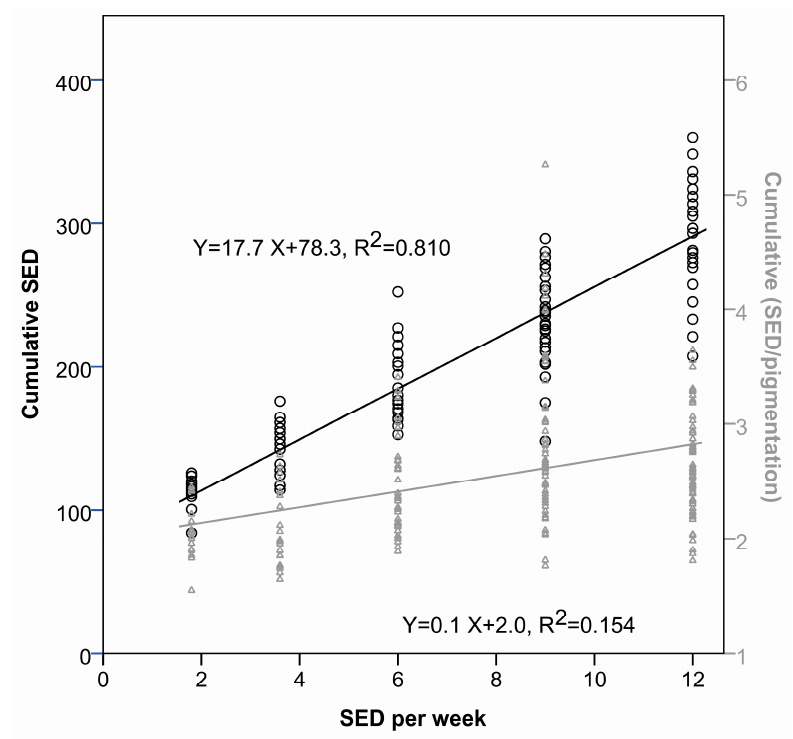
Figure 5. Linear relation between the cumulative dose at tumor development and the weekly irradiation dose (black). When mice receive fewer SED per week, they develop tumors after a longer time, regardless of the fact that the cumulative UVR dose are also lower. A linear relationship between the cumulative UVR dose corrected for pigmentation and the weekly UVR dose is shown in grey. This indicates that fewer SED per week still give tumors after lower cumulative UVR doses, but not as pronouncedly as before.